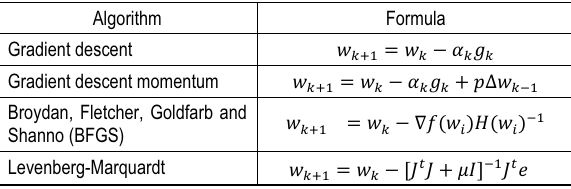
Table 1. Training algorithms used in models Algorithm